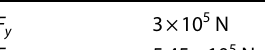
Table 2 Optimization input (as constants) regarding experimentally output hysteretic loop of tested